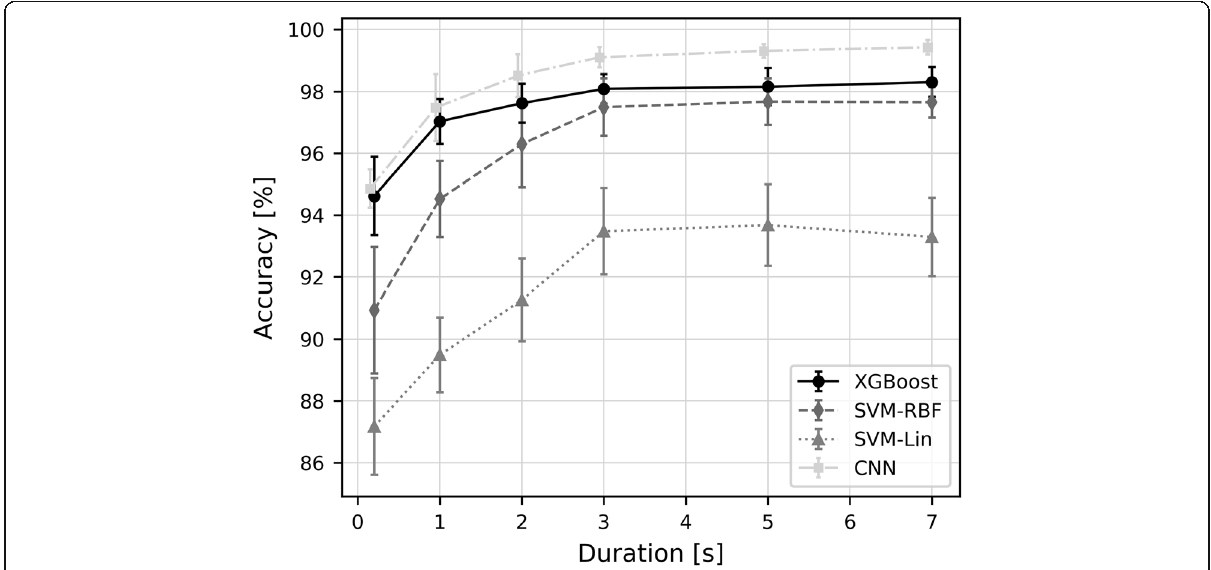
Fig. 13 The effect of duration of the audio excerpts on the discrimination results. Error bars denote standard